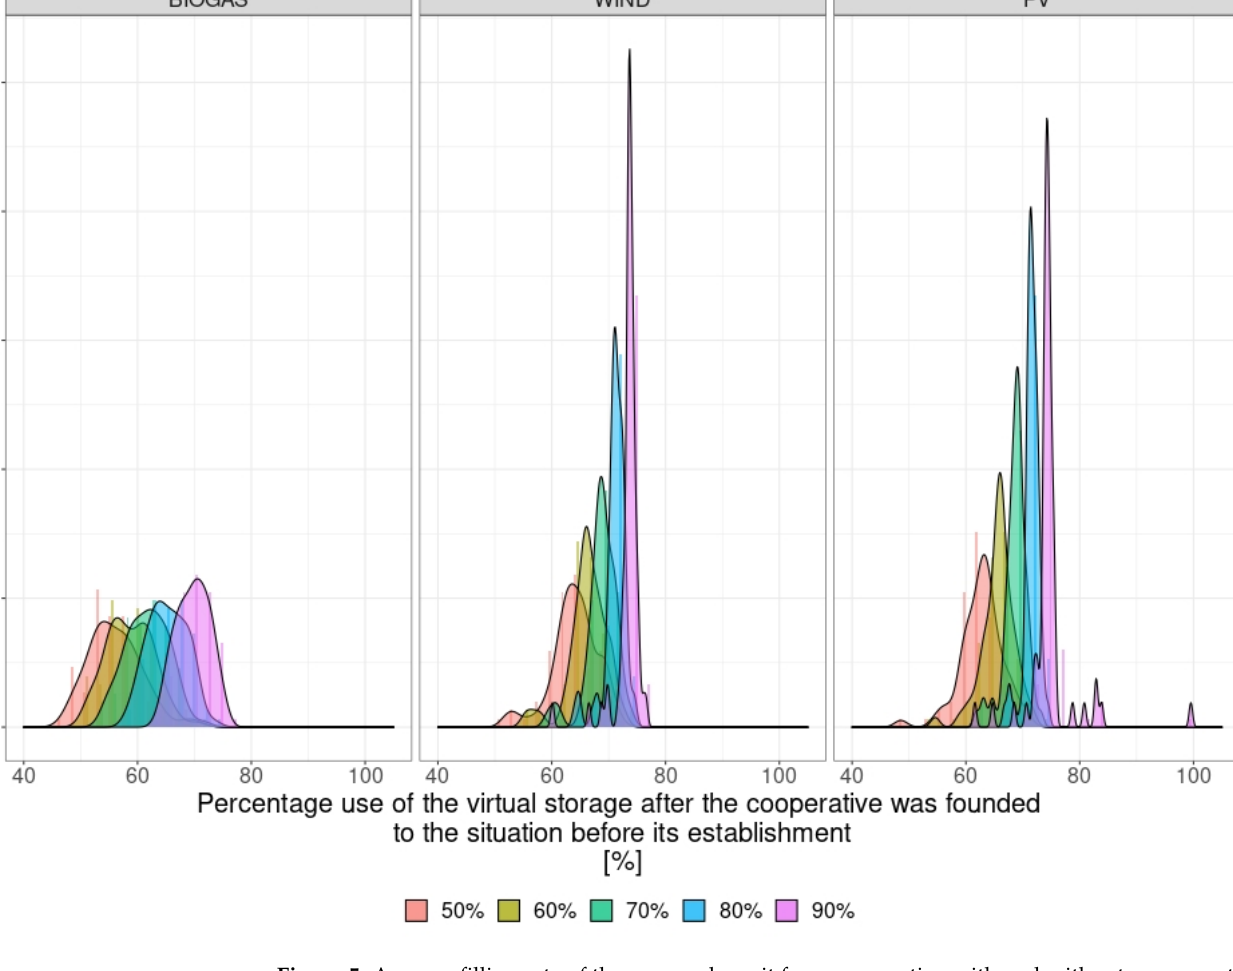
Figure 5. Average filling rate of the energy deposit for a cooperative with and without an excavator.